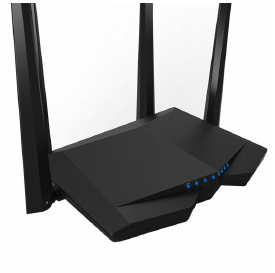
Figure 9. Tenda-AC1200 dual band WiFi smart